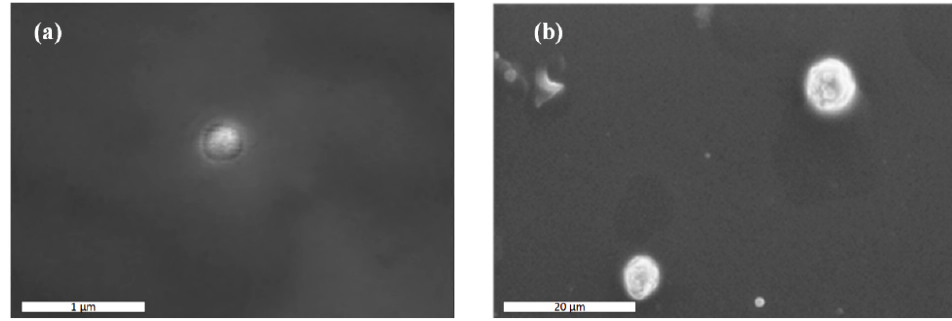
Figure 4. SEM images of CS-LFD ( a ) and CS-SDAEM-LFD ( b ) NPs.